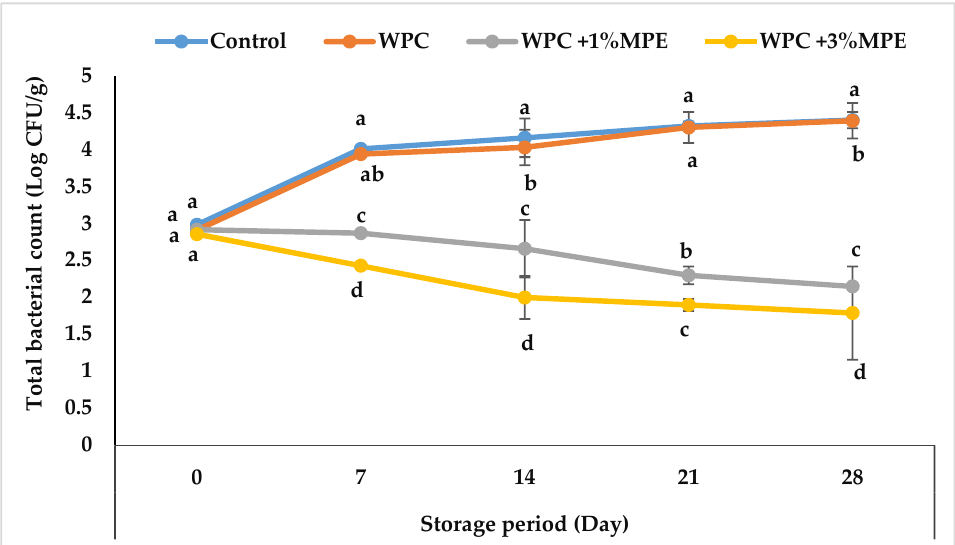
Figure 8. Effect of whey protein concentrate combined with mango peel extract (WPC = whey protein concentrate alone, WPC + 1% MPE = whey protein concentrate + mango peel extract at 1% and WPC + 3% MPE = whey protein concentrate + mango peel extract at 3%) on total bacterial count of broccoli fresh-cuts at 5 °C. Vertical bars indicate standard deviation (n = 6). Means and different letters indicate significant difference between treated and control broccoli for each storage period (Duncan’s multiple range test at 95%).